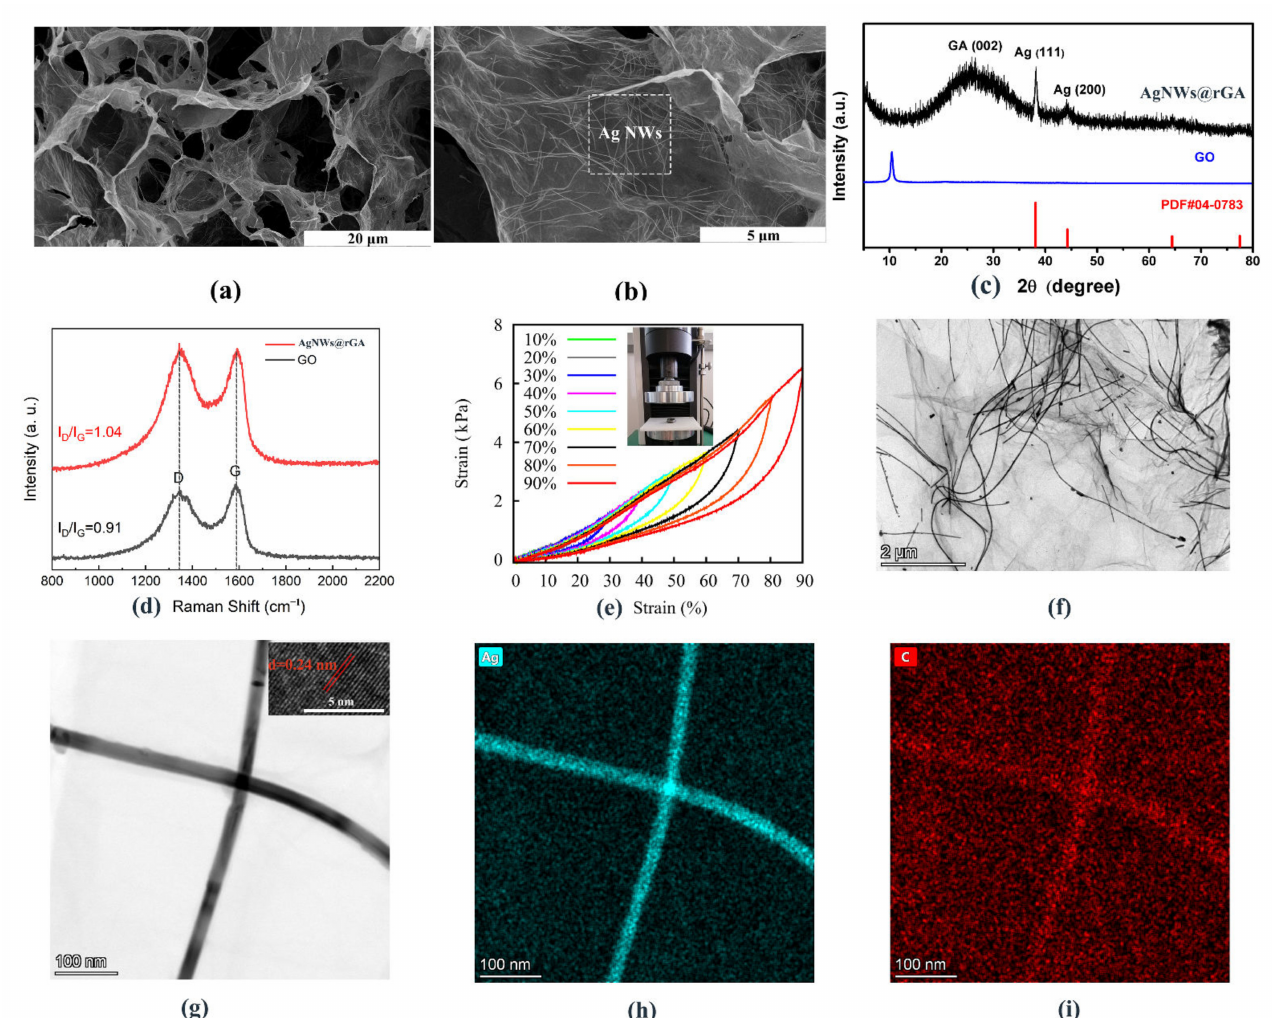
Figure 1. ( a , b ) SEM images of AgNWs@rGA composite aerogel spring. ( c ) XRD patterns of Ag- NWs@rGA together with pure GO. ( d ) Raman spectra of AgNWs@rGA. ( e ) Compressible stress–strain curves of AgNWs@rGA under strain of 10%, 20%, 30%, 40%, 50%, 60%, 70%, 80%, and 90%, respec- tively. The insets represent the photo image of AgNWs@rGA composite and testing device. ( f ) TEM images of AgNWs@rGA. ( g ) HRTEM image of AgNWs@rGA. ( h , i ) EDS mapping of the elements Ag and